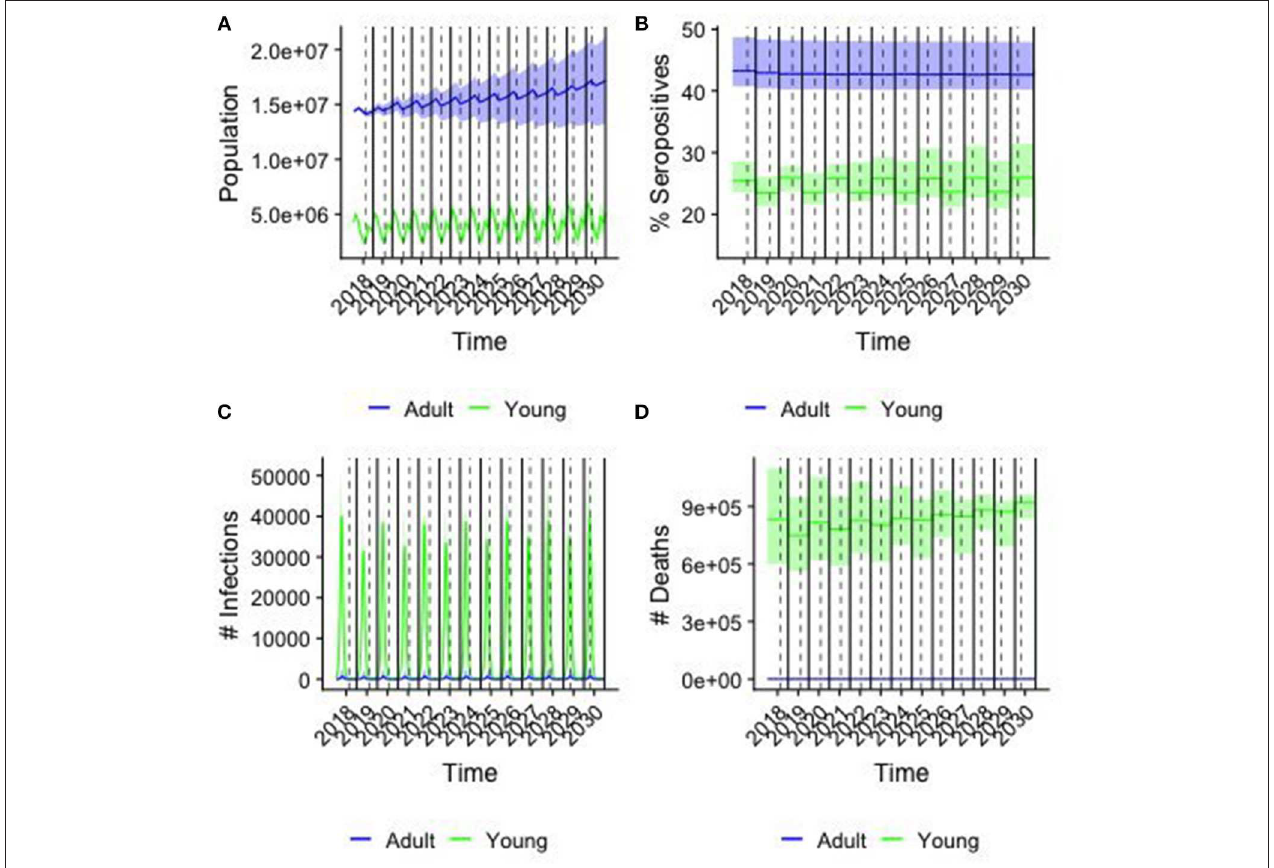
FIGURE 5 | Results from the baseline case. colors correspond to young ( < 1 year old) and adults ( > 1 year old), solid line corresponding of the median and shaded area the 95% confidence interval of the simulations over a sample of 250 parameter values. Solid lines indicate the end/beginning of the year, while dashed line indicates Tabaski date. (A) The population in each age group by day (B) the percentage of seropositive animals in each group (C) the number of new infections by day (D) the cumulative number of PPR-related deaths by